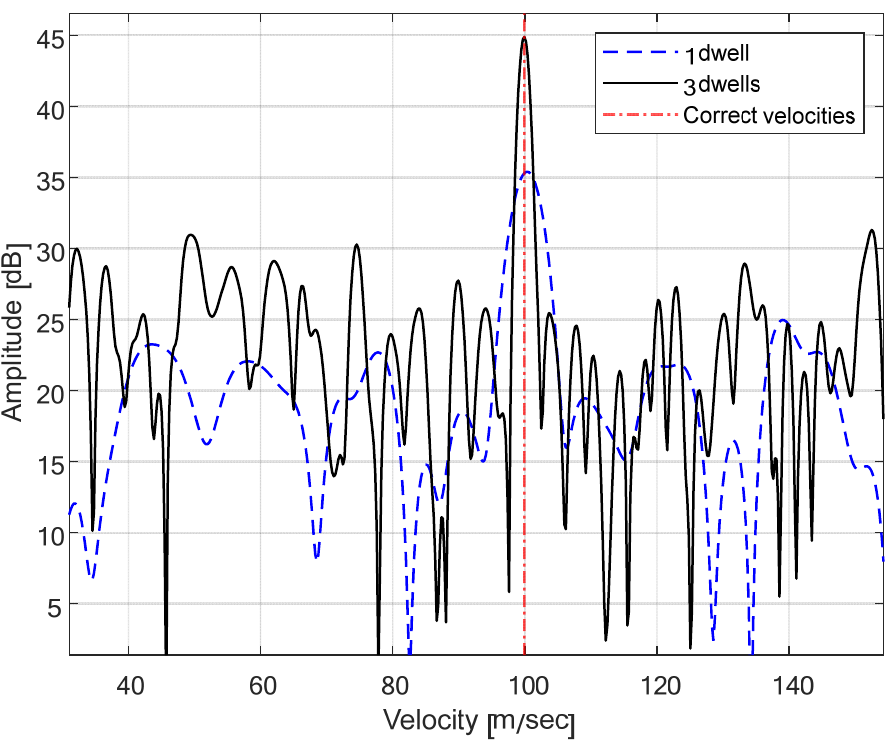
Figure 5. Velocity estimation for single dwell and concatenated 3 dwells.